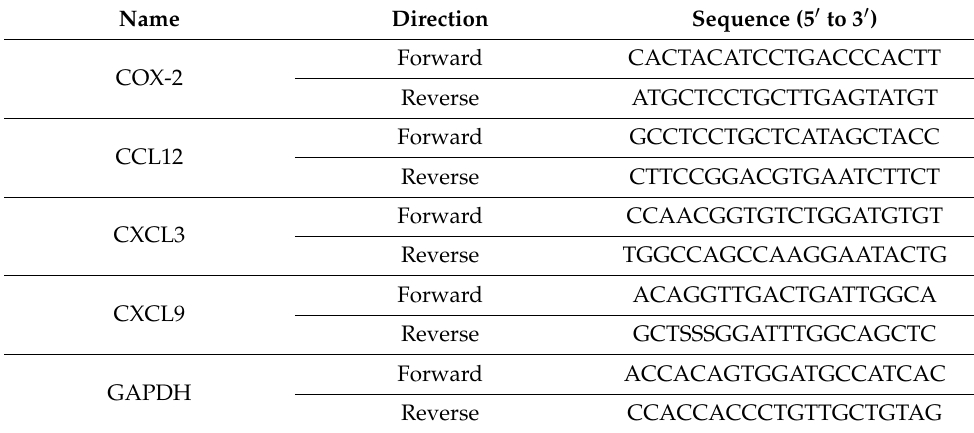
Table 1. Primer sequences for analysis of mRNA prepared from RAW264.7 cells used in